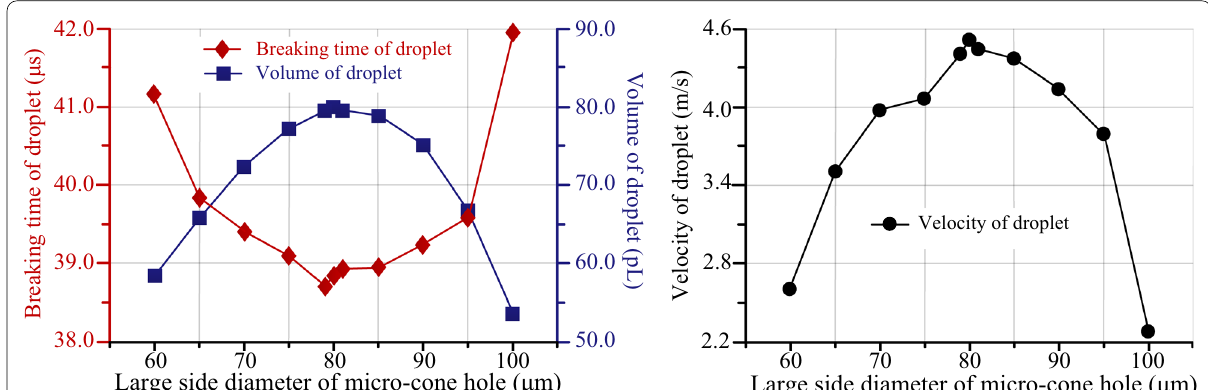
Figure 14 The relationship among breaking time of droplet, volume of droplet, velocity of droplet and large side diameter of micro-cone